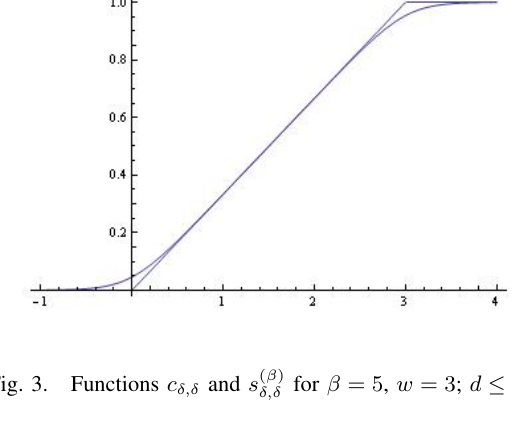
Fig. 3. Functions c δ,δ and s ( β )